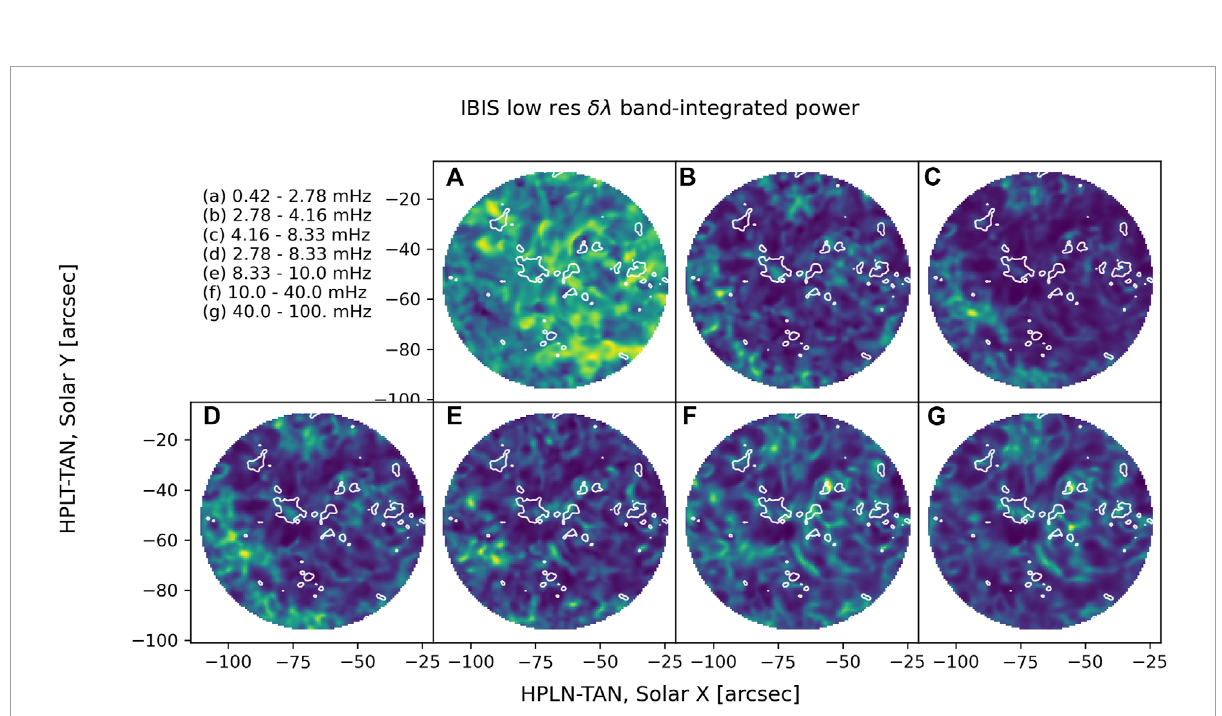
FIGURE 12 Same as Figure 11 but for the IBIS line width data spatially convolved and downsampled to match ALMA, and temporally subsampled to the overlapping times { t O } . The frequency bands correspond to: (A) low frequencies; (B) 5 min oscillations; (C) 3 minute oscillations; (D) combined p-modes; (E) near-cutoff; (F) mid frequencies; (G) high